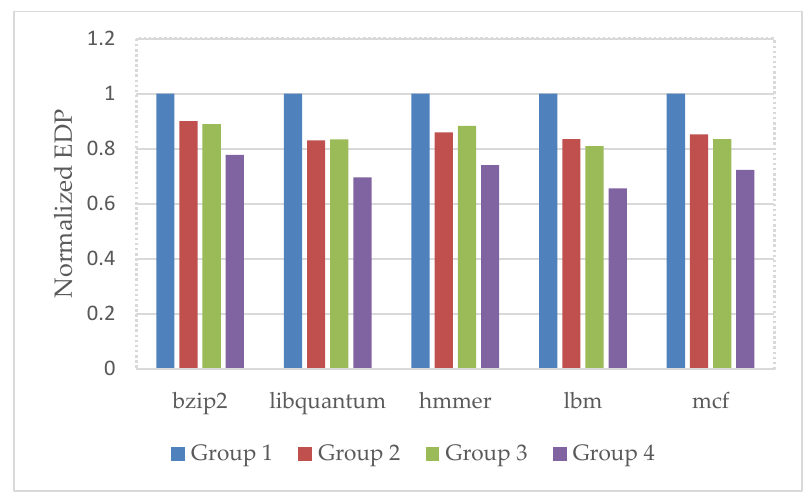
Figure 10. Comparison of Energy-Delay Product normalized to Group 1.